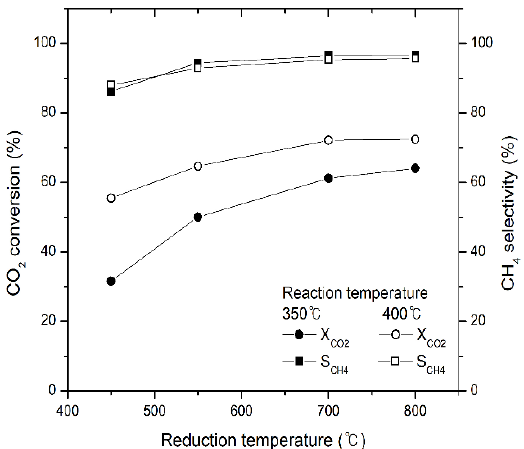
Figure 9. Effect of reduction temperature on CO 2 conversion and CH 4 selectivity over the 40 wt% Ni-Mg-Al catalyst.